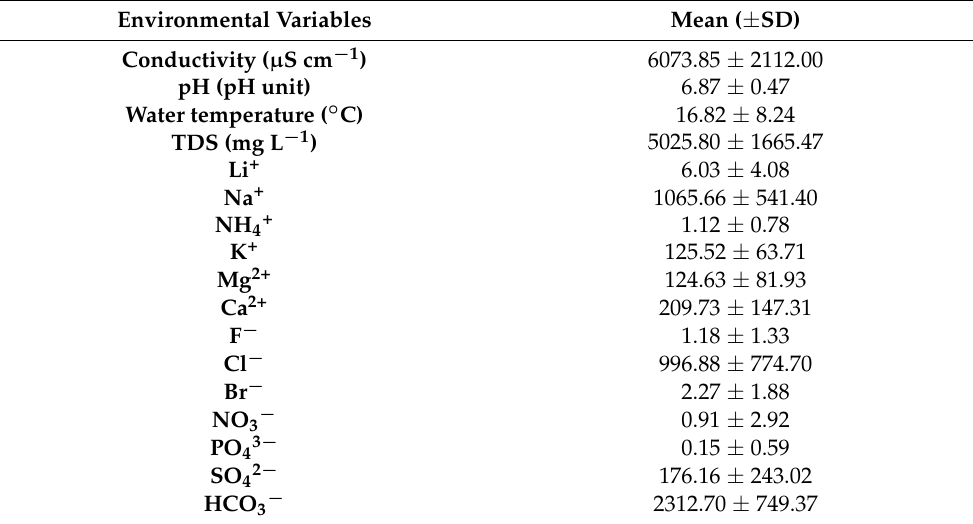
Table 1. Environmental variables measured at the study sites: parameters measured in situ, TDS and cation and anion concentrations (in mg L − 1